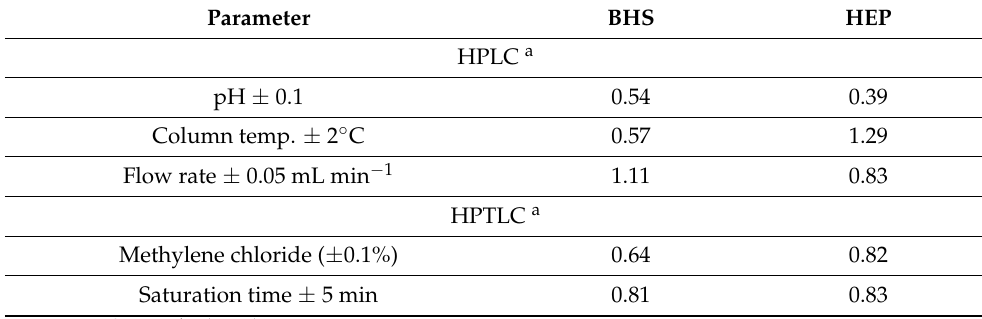
Table 3. Robustness of the proposed methods for the determination of BHS and HEP.